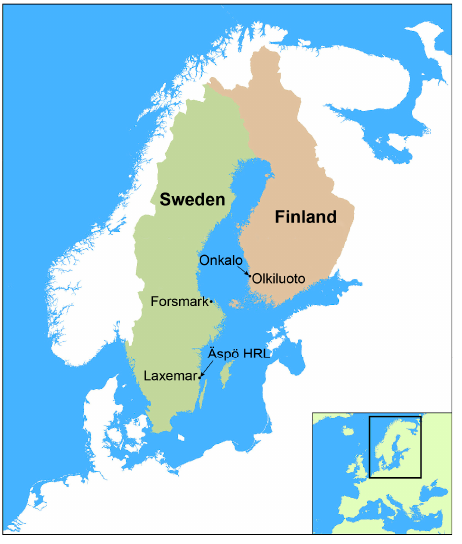
Figure 1. The Äspö Hard Rock Laboratory (ÄHRL) is located in the archipelago near Laxemar in Sweden and the underground rock facility ONKALO is located on the island Olkiluoto in Finland (map taken from [3]). Presently, besides SKB, the participating organizations are BMWi (Germany), DOE (USA), NUMO (Japan), NWMO (Canada), KAERI (South Korea), Posiva (Finland), SÚ- RAO (Czech Republic) and TPC (Taiwan). Other organizations that have been members are, e.g., ANDRA (France), CRIEPI (Japan), ENRESA (Spain), JAEA (Japan), PNC/JNC (Ja- pan), NAGRA (Switzerland), and UK Nirex/RWM (United Kingdom). Commonly, each organization provides at least one modeling team that can be in-house, a consultant or from academia. Normally, at least one PhD student is involved in each task. More infor- mation on SKB TFGWFTS may be found at www.skb.se/taskforce (accessed on 27 Decem- ber 2022). 2.2. From Task 1 to Task 10 Below, we provide a short summary of each task, and of its motivation and execution. The main results and how the results have been used in performance and safety assess- ment studies are discussed in Section 3. The tasks have been chosen to support the exper- iments performed at ÄHRL and ONKALO, for being beneficial for the participating or- ganizations and to be useful for the model developments.